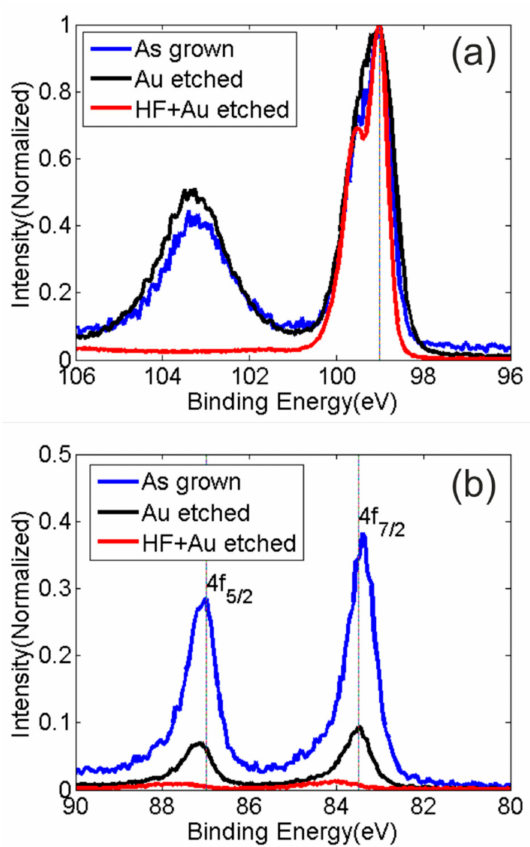
Figure 5. High resolution X-ray photoelectron spectra of the ( a ) Si 2p and ( b ) Au 4f of the as-grown nanowires (blue line), the sample obtained after the gold etching (black line) and the sample obtained after the two-step procedure (red line).